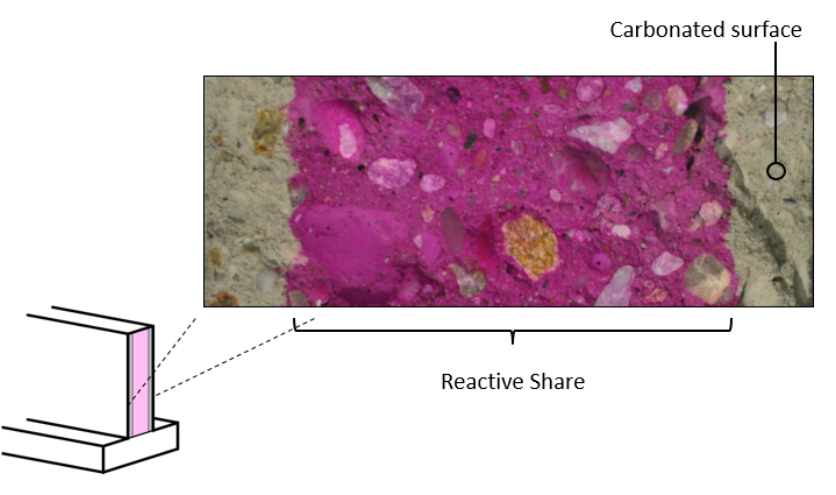
Figure 1. Not-carbonated share of a cross-section.